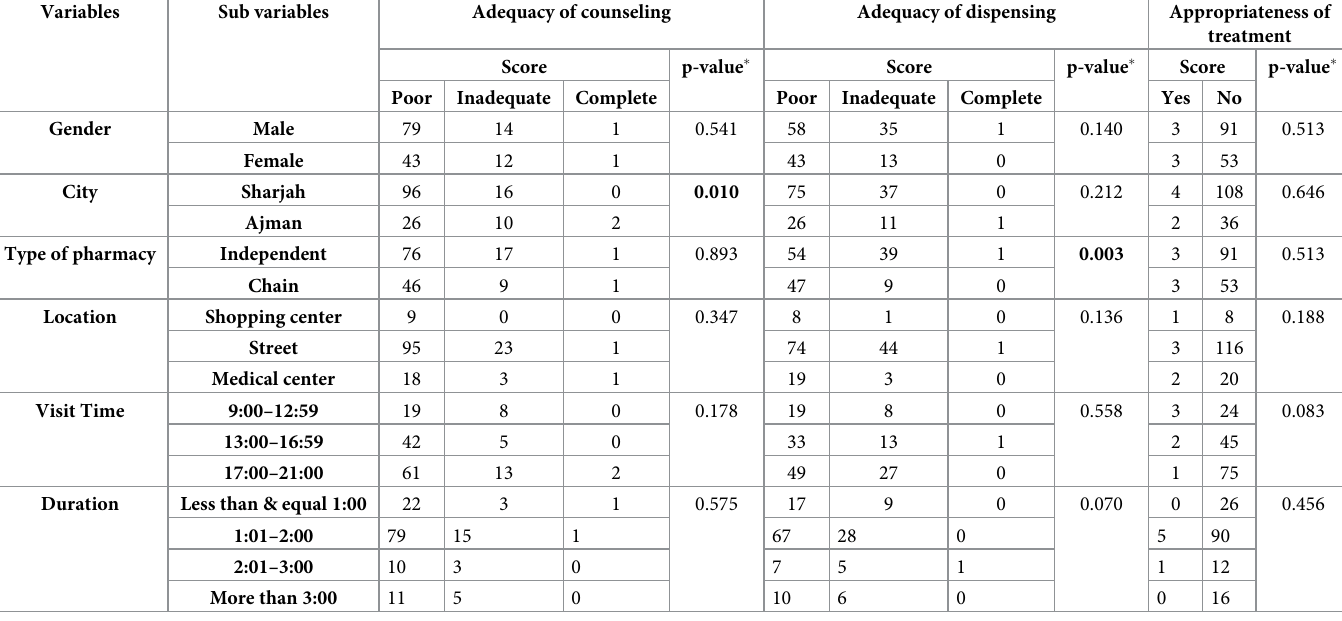
Table 6. Factors affecting pharmacist’s